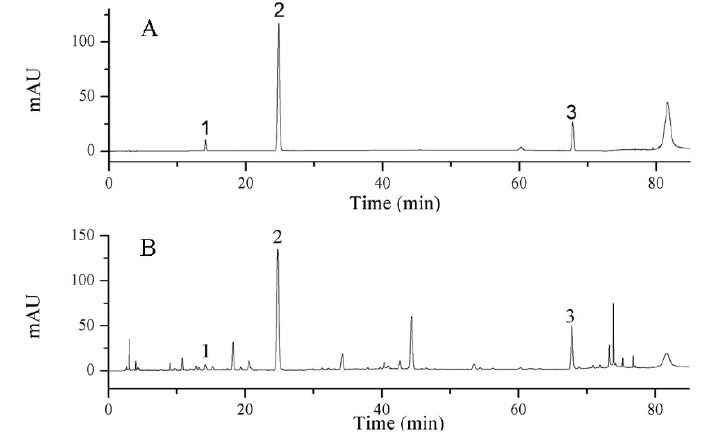
Figure 7. HPLC chromatograms of ( A ) standard solution (1. epigoitrin, 2. geniposide, 3. baicalin) and ( B ) LOS sample.